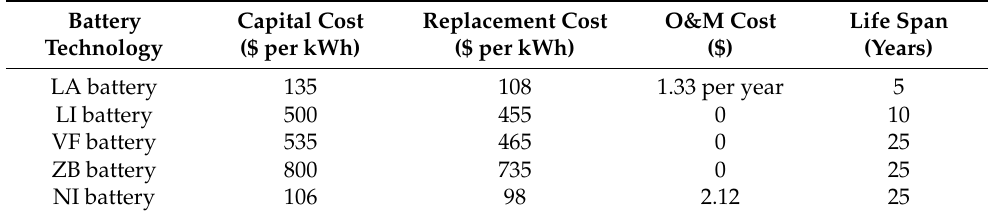
Table 2. Financial metrics of different battery technologies.